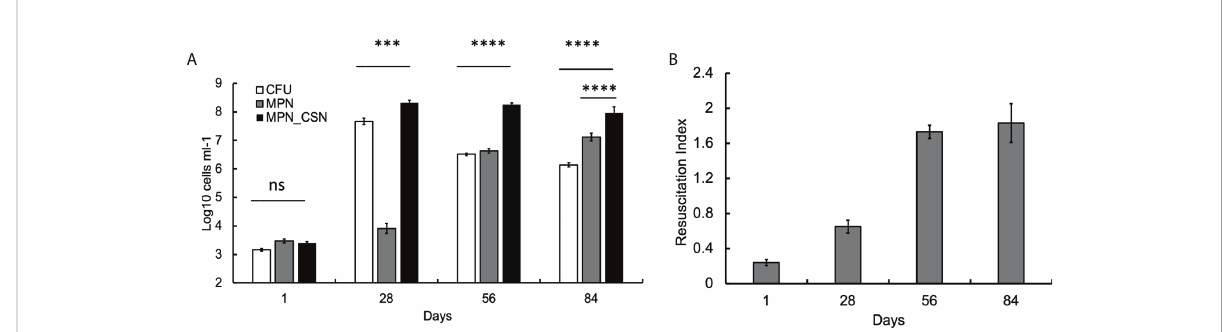
FIGURE 1 Assessment of Mtb loads in the infected murine lungs over a 12-week infection period. Mice were culled after 1, 28, 56 and 84 days of infection. At 56 and 84 days, mice received PEG (no treatment control). (A) CFU, MPN and MPN_CSN counts were determined in the lung homogenates. Data shown as means ± STDV ( N = 5). (B) The resuscitation indices were calculated using the following formula: RI = log 10 (MPN_CSN ml -1 ) – log 10 (CFU ml -1 ). Ns, non-signi fi cant; p > 0.05; *** p < 0.001; **** p < 0.0001 unpaired t